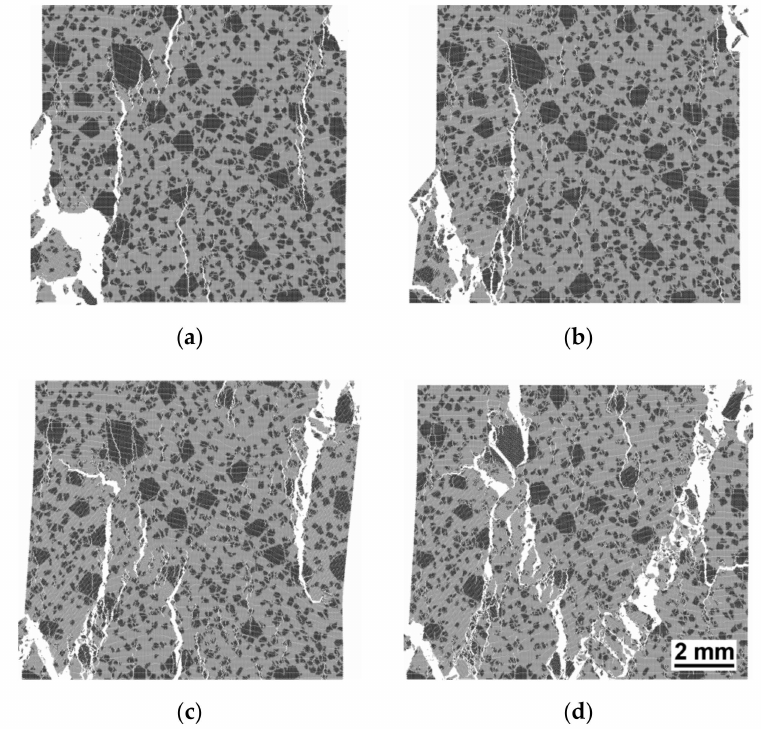
Figure 11. Fracture patterns under dynamic compression for the strain rates of 5 s − 1 ( a ), 10 s − 1 ( b ), 50 s − 1 ( c ), and 100 s − 1 ( d ).